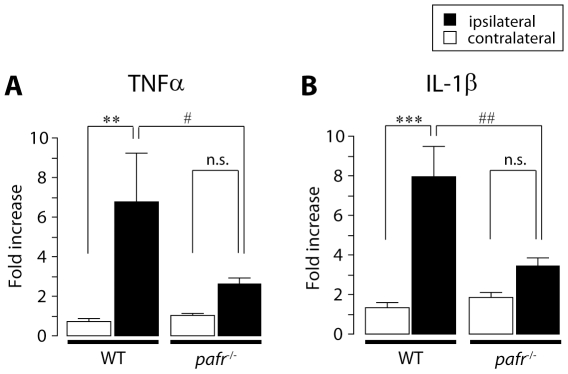
Upregulation of TNFα and IL-1β gene expression in the DRG is reduced in pafr
−/− mice.A, B. Real-time PCR analysis demonstrated that following nerve injury, the expression of TNFα (A) and IL-1β (B) mRNAs in the ipsilateral DRG of wild-type mice was much higher than in the contralateral side on day 7. However, pafr
−/− mice failed to show upregulation of these cytokines and there were significant differences in these expressions of the ipsilateral side between wild-type and pafr
−/− mice. Each measurement was normalized to 18S mRNA content. **p<0.01, ***p<0.001 compared with the contralateral side of wild-type mice. #p<0.05, ##p<0.01 compared with the ipsilateral side. n.s. means “not significant”. All data are presented as mean ± SEM of six to eight animals.